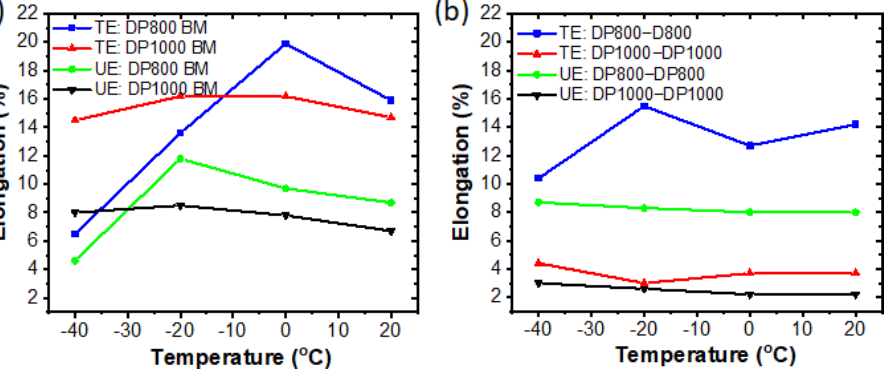
Figure 9. Elongation as a function of deformation temperatures for ( a ) DP800 and DP1000 BMs, ( b ) welded DP800 and DP 1000 joints, at different deformation temperatures from 20 °C to −40 °C .